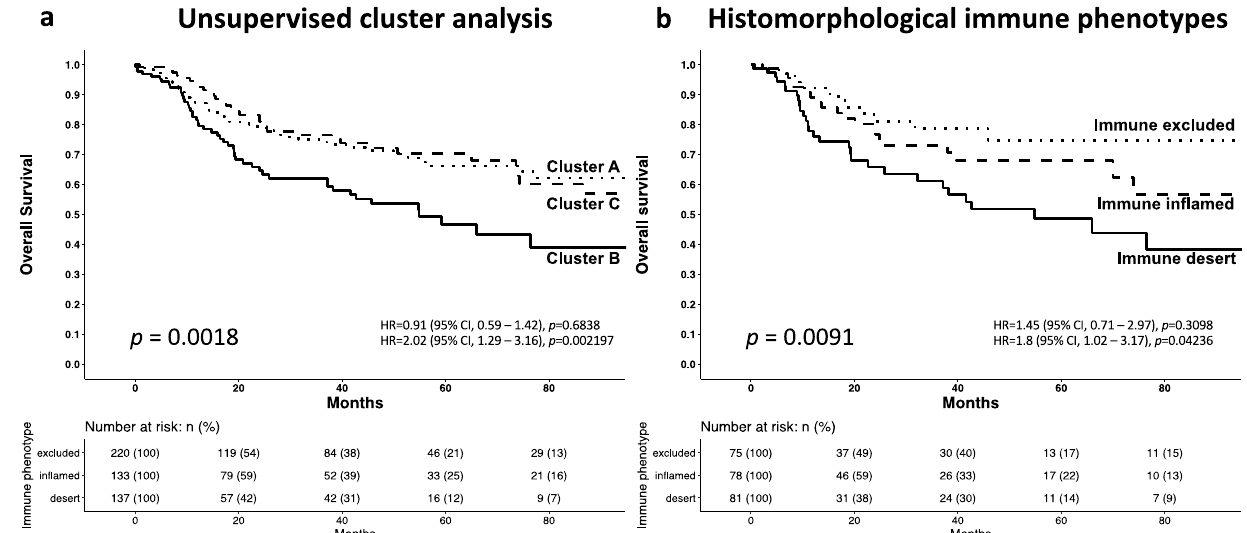
Figure 4. Kaplan–Meier Estimates for overall survival among patients with different immune phe-